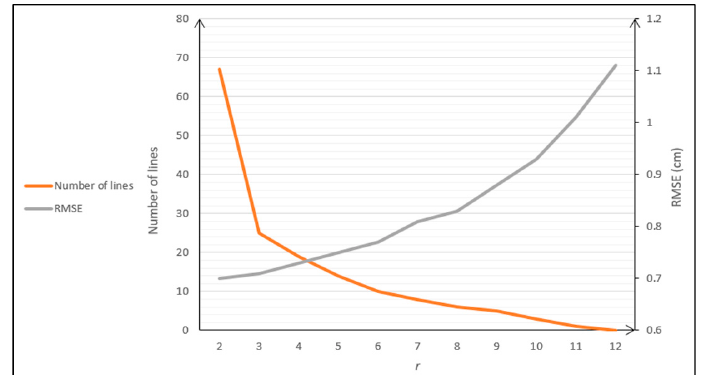
Figure 10. Change of RMSE of LAP-SLAM and the number of lines with r .